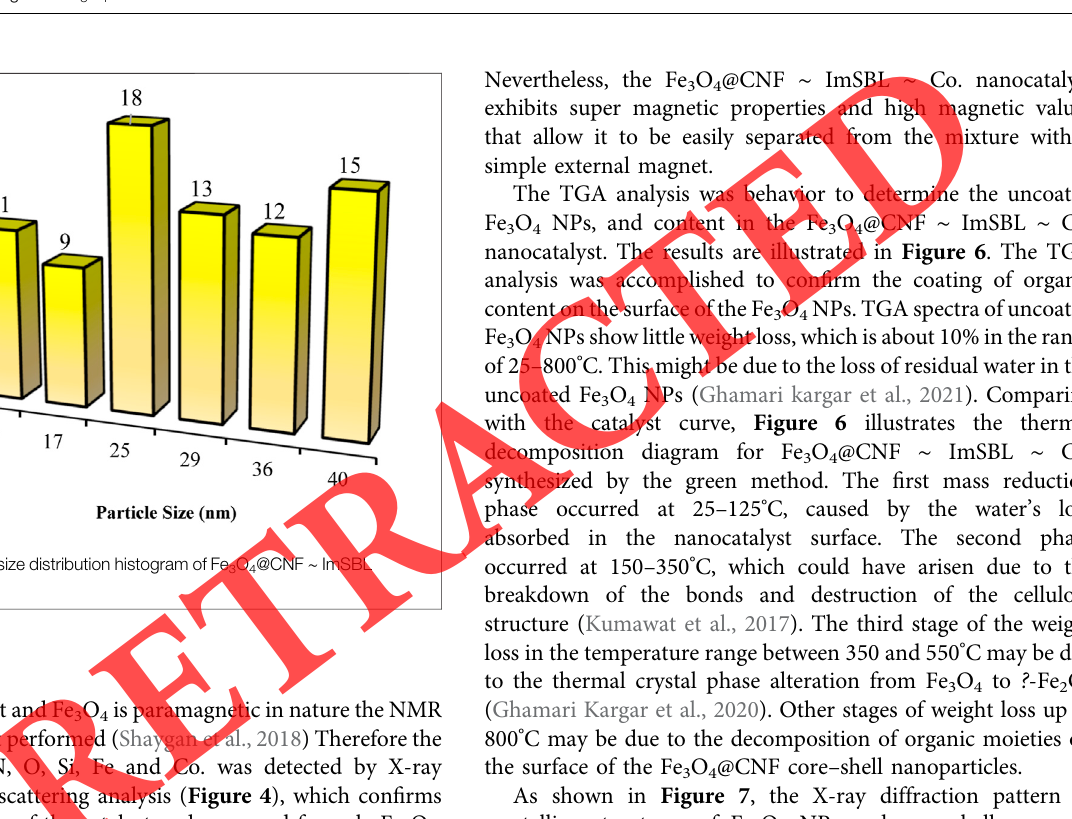
FIGURE 2 | TEM images of Fe 3 O 4 @CNF ∼ ImSBL ∼ Co.